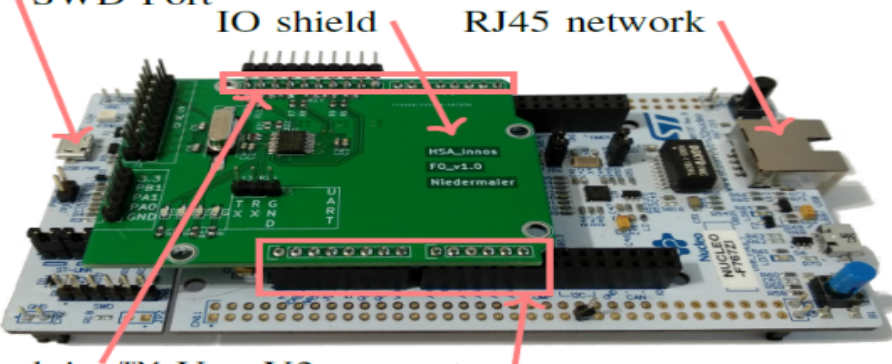
Figure 6. IoT device used in performance evaluation.